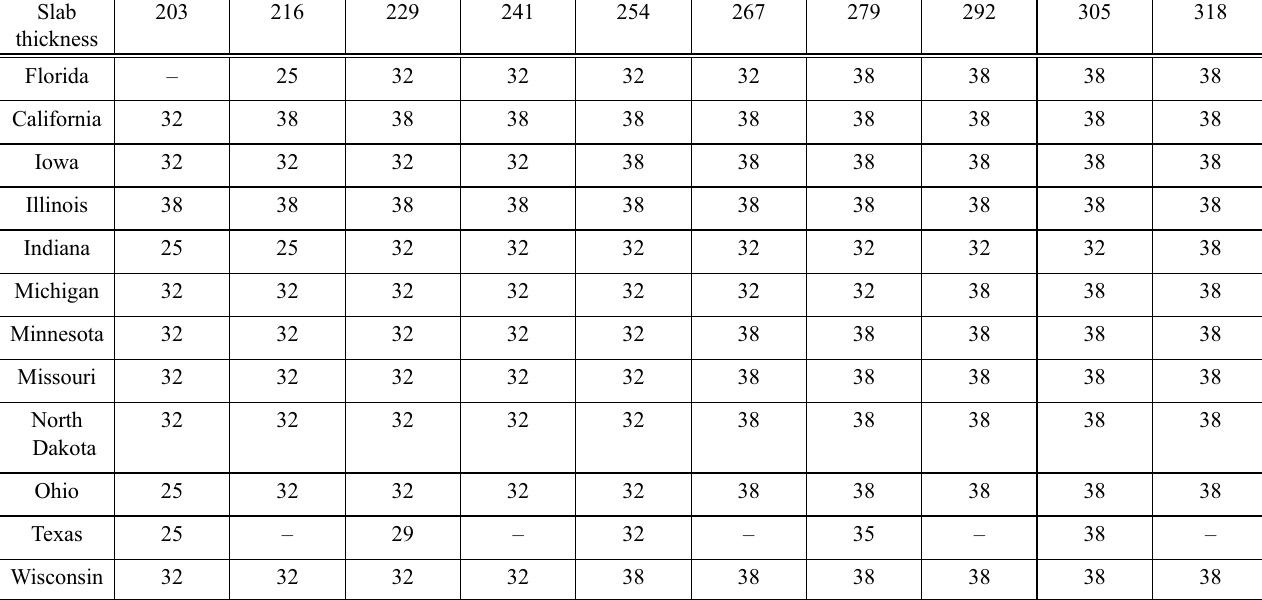
Table 1 Recommended dowel bar diameter versus pavement slab